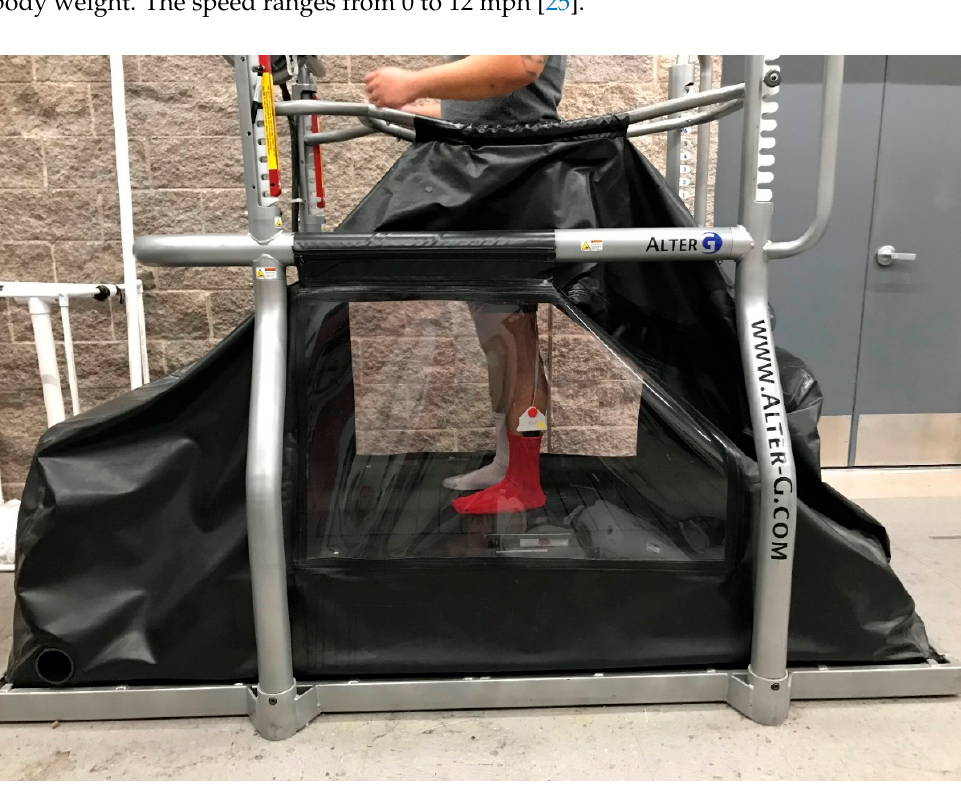
Figure 1. Subject using AlterG ® Treadmill with Medilogic ® Pressure-Measuring Insoles.